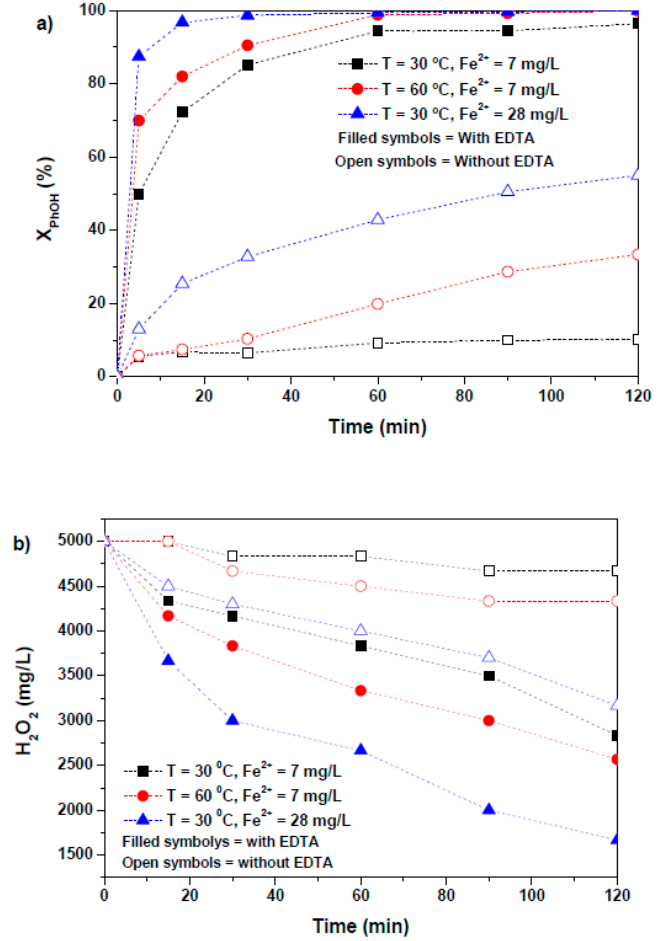
Figure 5. Effect of temperature and Fe concentration on ( a ) phenol and ( b ) H 2 O 2 conversion. [Phenol] = 1000 mg/L, [H 2 O 2 ] 0 = 5000 mg/L, [pH] 0 = 7.0, L:M = 0.3:1, and t = 120 min.